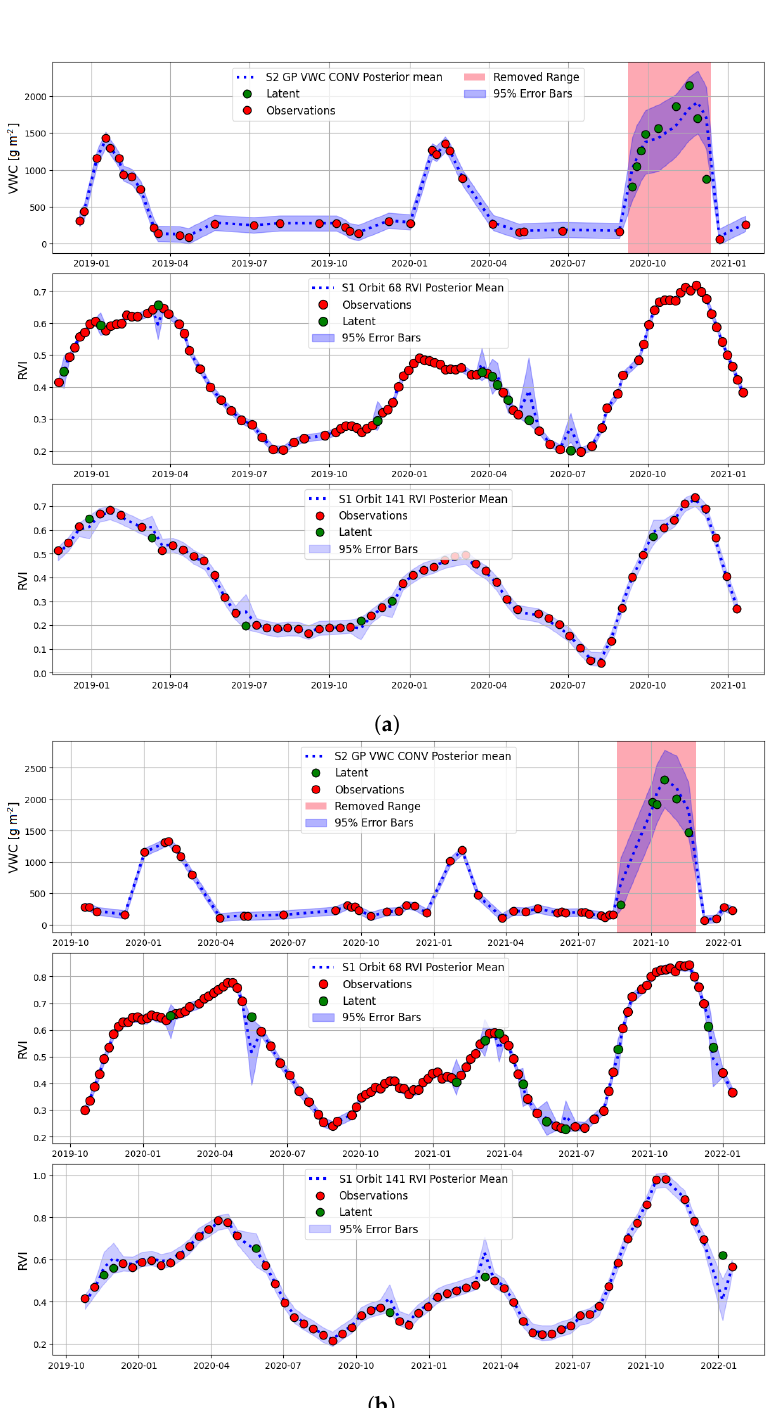
Figure 7. CONV posterior predicted mean for a three-channel model. Red dots indicate the original observations for S2 GP VWC (CH-1), S1 RVI orbit 68 (CH-2), and S1 RVI orbit 141 (CH-3) while the green ones are the latent samples. Winter wheat 2020 ROI-1 ( a ). Winter wheat 2020 ROI-2 ( b